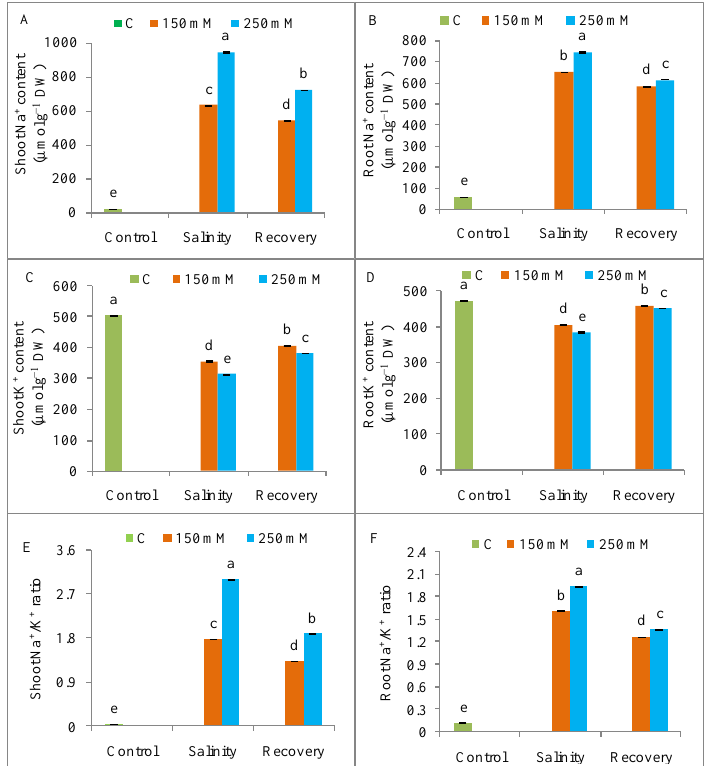
Figure 4. Content of Na + , K + and Na + /K + ratio ( A ) shoot Na + , ( B ) root Na + , ( C ) Shoot K + , ( D ) Root K + , ( E ) Shoot Na + /K + ratio, and ( F ) root Na + /K + in tomato plants under salinity (150 and 250 mM NaCl) and after a 48 h recovery period. Data means (±SD) were calculated from three replications. Statistically significant values are indicated by dissimilar letters (Fisher’s LSD test, P ≤ 0.05).